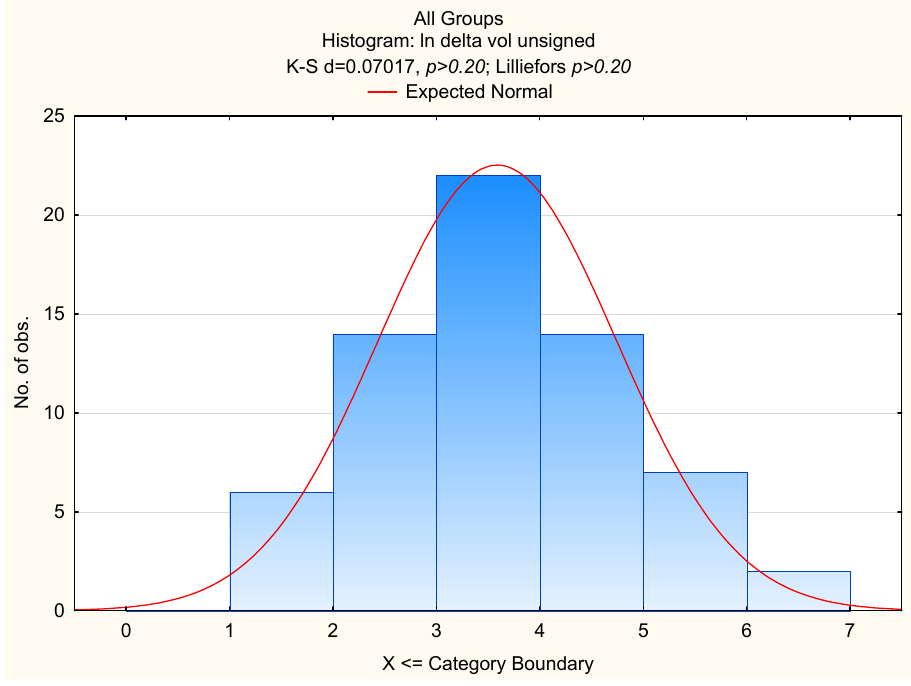
Figure 3. Log of breast volume fluctuating asymmetry in women with different breast sizes.